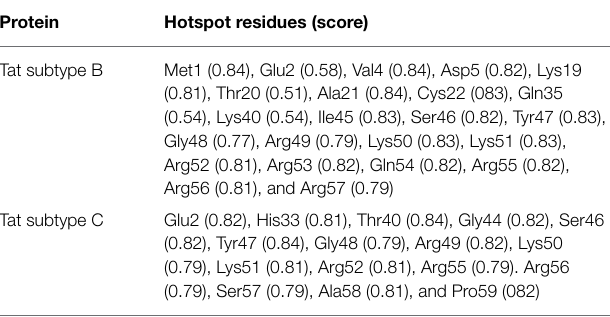
TABLE 4 | Prediction of Protein–RNA binding energy hot spots between Tat subtype B and C and TAR. Protein Hotspot residues